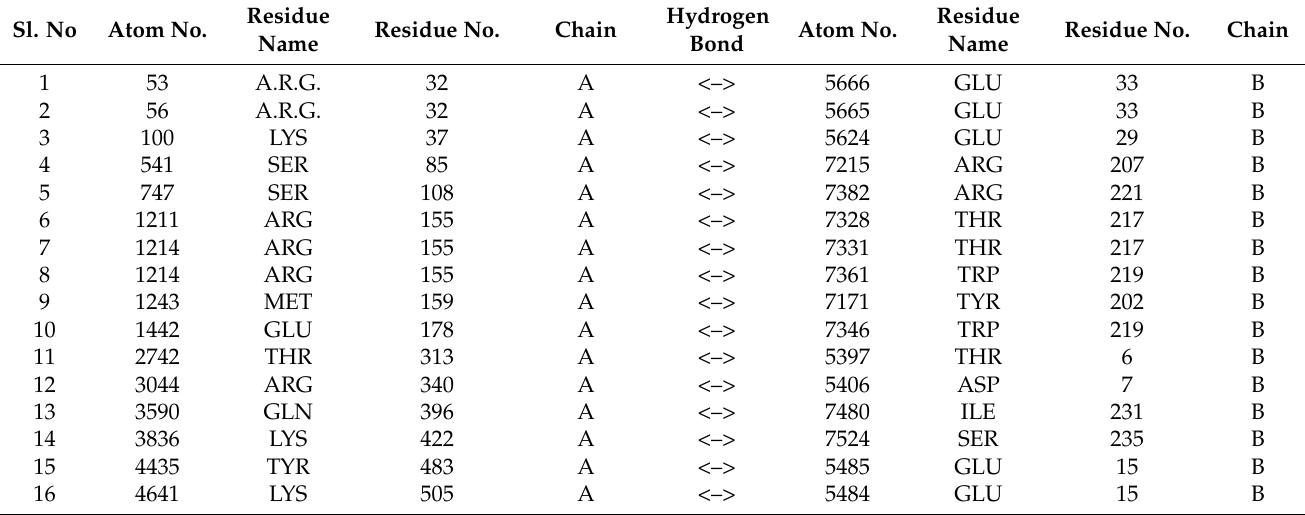
Table 4. Hydrogen bonds between Chain A (TLR2) and Chain B (vaccine) of TLR2—vaccine